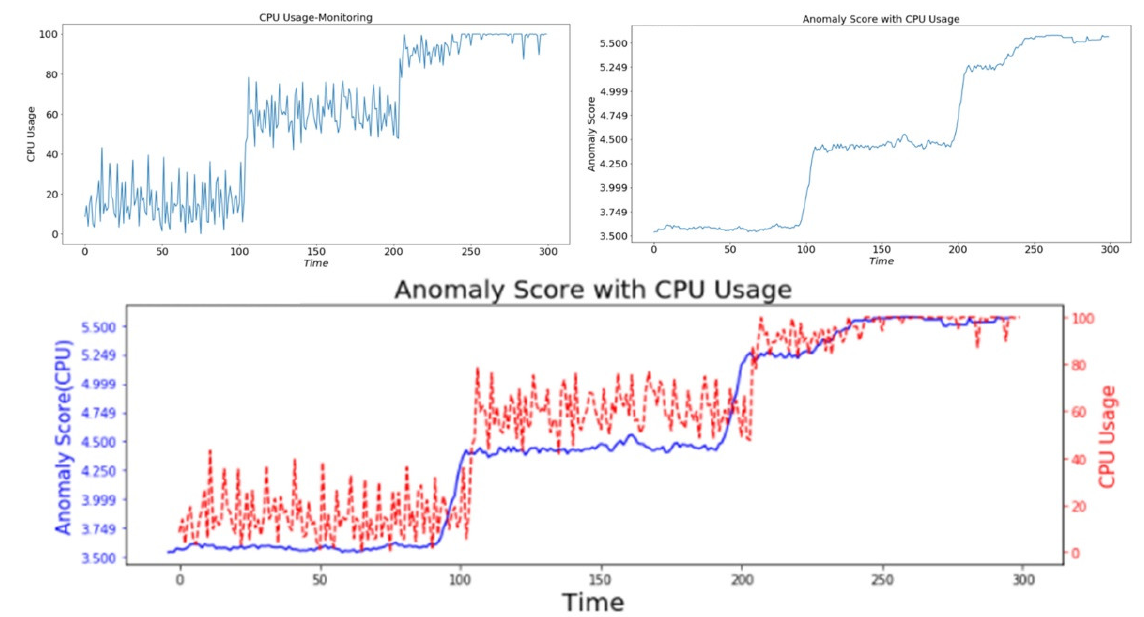
Figure 8. Anomaly Score (CPU Fault-Accumulative).